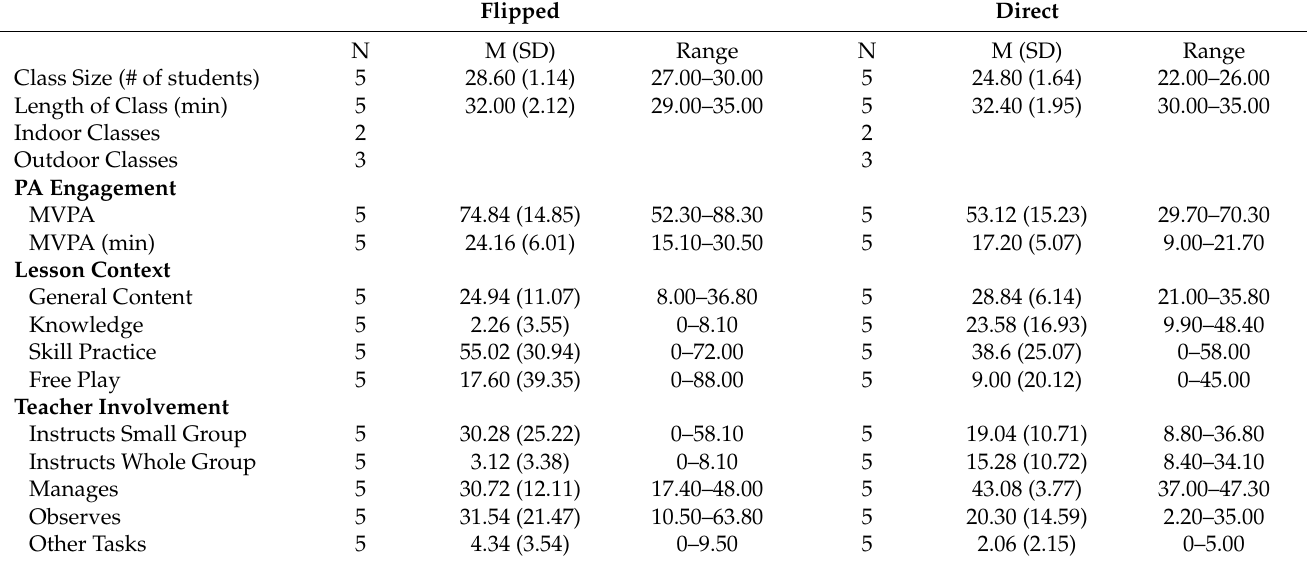
Table 1. Descriptive Statistics of SOFIT Variables of Interest in Physical Education Classes Using Flipped Learning and Direct Instruction